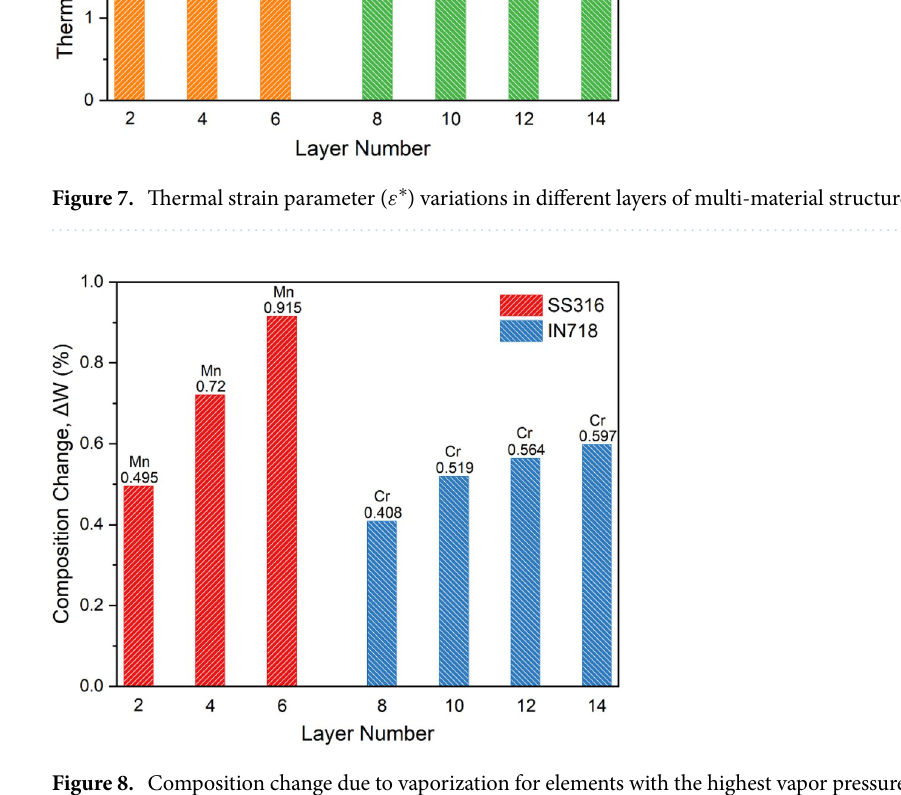
Figure 8. Composition change due to vaporization for elements with the highest vapor pressure in different layers of the multi-material structure.